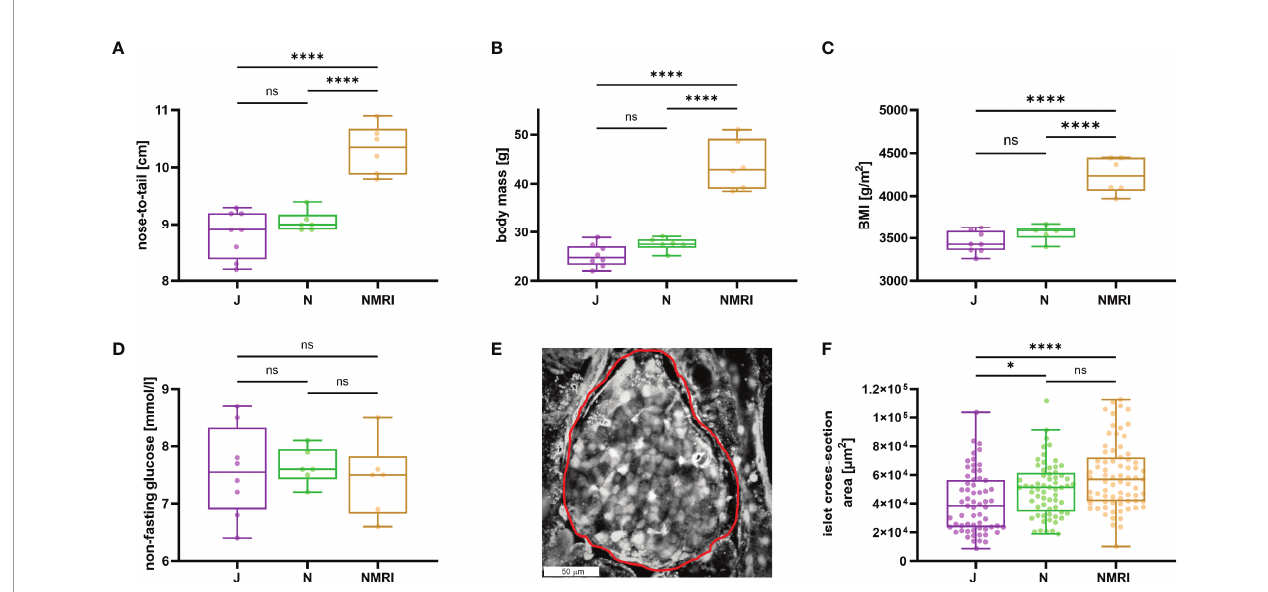
FIGURE 1 | Physiological parameters of C57BL/6J, C57BL/6N, and NMRI mice. (A) Nose-to-tail length. (B) Body mass. (C) Body mass index calculated as the ratio between body weight and body surface area (g/m 2 ). (D) Non-fasting glucose concentration. Data for panels A-D were obtained from 8 C57BL/6J, 6 C57BL/6N, and 6 NMRI mice. (E) Representative islet of Langerhans. The islet border is marked with a red line. (F) Islet cross-section area in the pancreas tissue slice (median values 38 373 m m 2 vs. 51 267 m m 2 vs. 56 861 m m 2 for C57BL/6J, C57BL/6N, and NMRI, respectively) obtained from 63/7, 64/6, 75/6 islets/mice from C57BL/6J, C57BL/6N, and NMRI mice respectively. Where present, the following symbols in indicate p-values: *p < 0.05, **p < 0.01, ***p < 0.001, ****p < 0.0001; ns, not signi fi